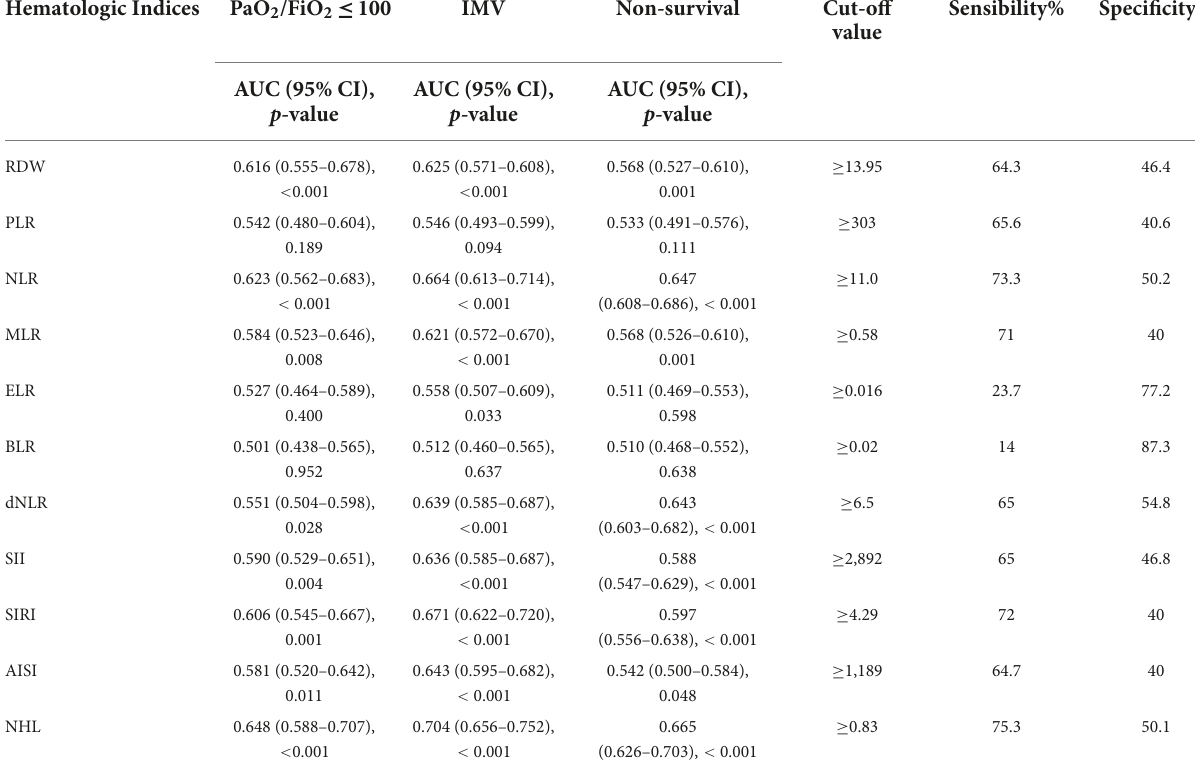
TABLE 2 Predictor values of systemic inflammation indices on severity and non-survival in COVID-19 patients. Hematologic Indices PaO 2 /FiO 2 ≤ 100 IMV Non-survival Cut-off